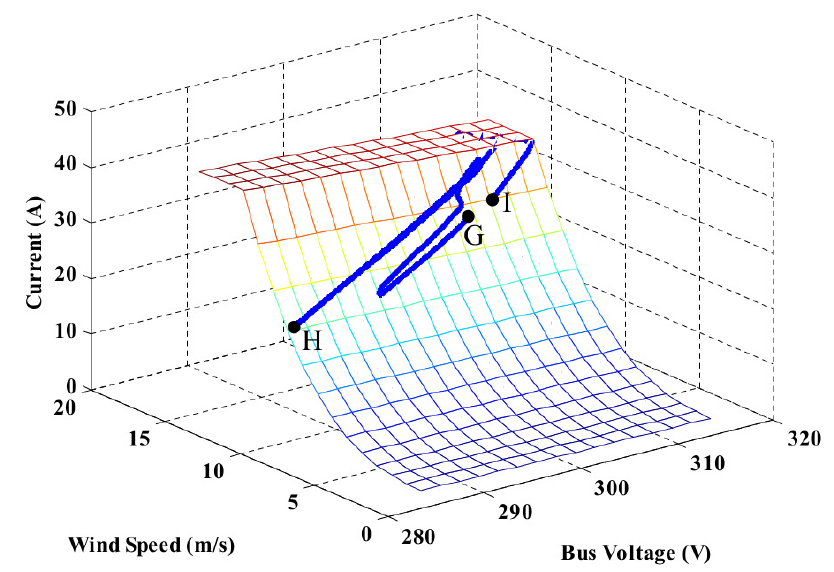
Figure 20. Optimal multidimensional droop control relationship for the third simulation.